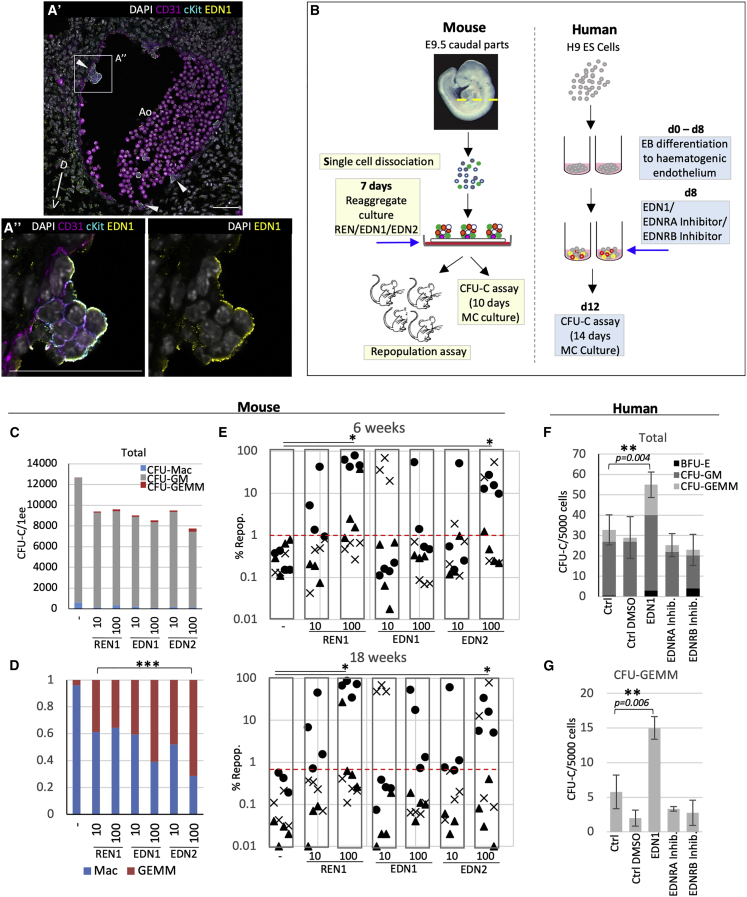
Endothelins Promote Hematopoiesis in the Mouse and Human Model Systems(A) CD31, cKit, and EDN1 immunostaining in the Ao of an E10.5 mouse embryo. Arrowheads indicate cKit+EDN1+ IAHCs or individual emerging Hem cells. The images in (A’’) show a magnification of the boxed region in (A’). Scale bars: 50 μm.(B) Experimental strategies for mouse and human model systems. MC, methocult.(C) Production of CFU-Cs in E9.5 caudal tissues cultured with each of the test factors (REN1, EDN1, and EDN2) at 10 ng/μL and 100 ng/μL. n = 4 independent experiments.(D) Proportion of CFU-Mac and CFU-GEMM from (B), normalized to 1; n = 4 independent experiments.(E) Repopulation with E9.5 caudal part cells cultured with the test factors (REN1, EDN1, and EDN2) and 18 weeks following transplantation (∗p < 0.05, paired t test, n = 3 independent experiments). The shape on the graph indicates the experiment. The red line shows the upper limit of control repopulation levels). The numbers of long-term repopulating mice (18 weeks) higher than 1% are as follows: CTRL, 0/11; REN1_10, 3/11; REN1_100, 5/12; EDN1_10, 3/11; EDN1_100, 3/12; EDN2_10, 2/11; EDN2_100, 6/12.(F) Effect of test factors on production of CFU-Cs by human ES cells at 12 days of differentiation. The number of day 14 CFU-Cs per 5,000 plated cells is shown; factors were added at day 8 of culture (∗∗p < 0.01, paired t test; error bars, ± SEM, n = 4).(G) Production of CFU-GEMM from (E) (∗∗p < 0.01, paired t test; error bars, ± SEM).